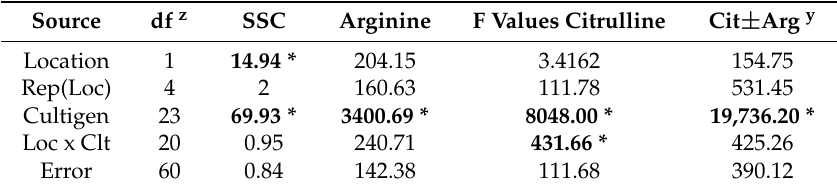
Table 2. Analysis of variance for four quality traits studied in 2 locations (loc), 3 replications (rep), and 24 cultigens (clt); all factors were considered to be random. Source df z SSC Arginine F Values Citrulline Cit ± Arg y